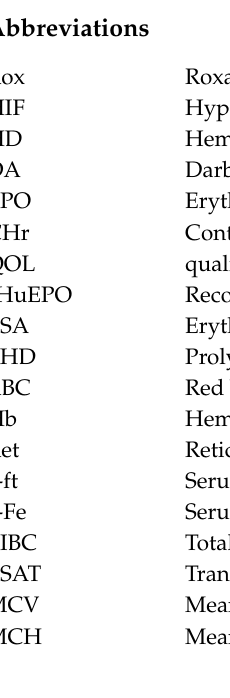
Figure S1: Comparison in erythrocyte indices and EPO concentration between the patients received Rox 70 mg and those received Rox 100 mg, Figure S2: Comparison in CHr, hepcidin levels and iron-related indices between the patients received Rox 70 mg and those received Rox 100